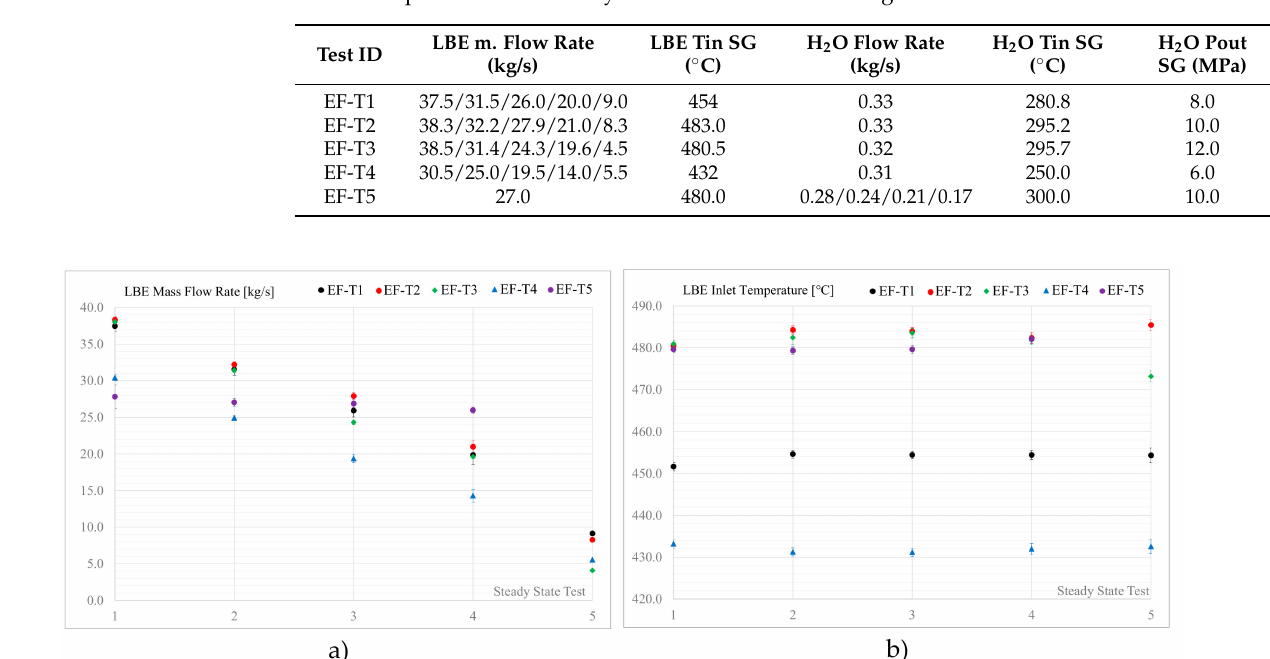
Table 2. Experimental boundary conditions achieved during the tests.